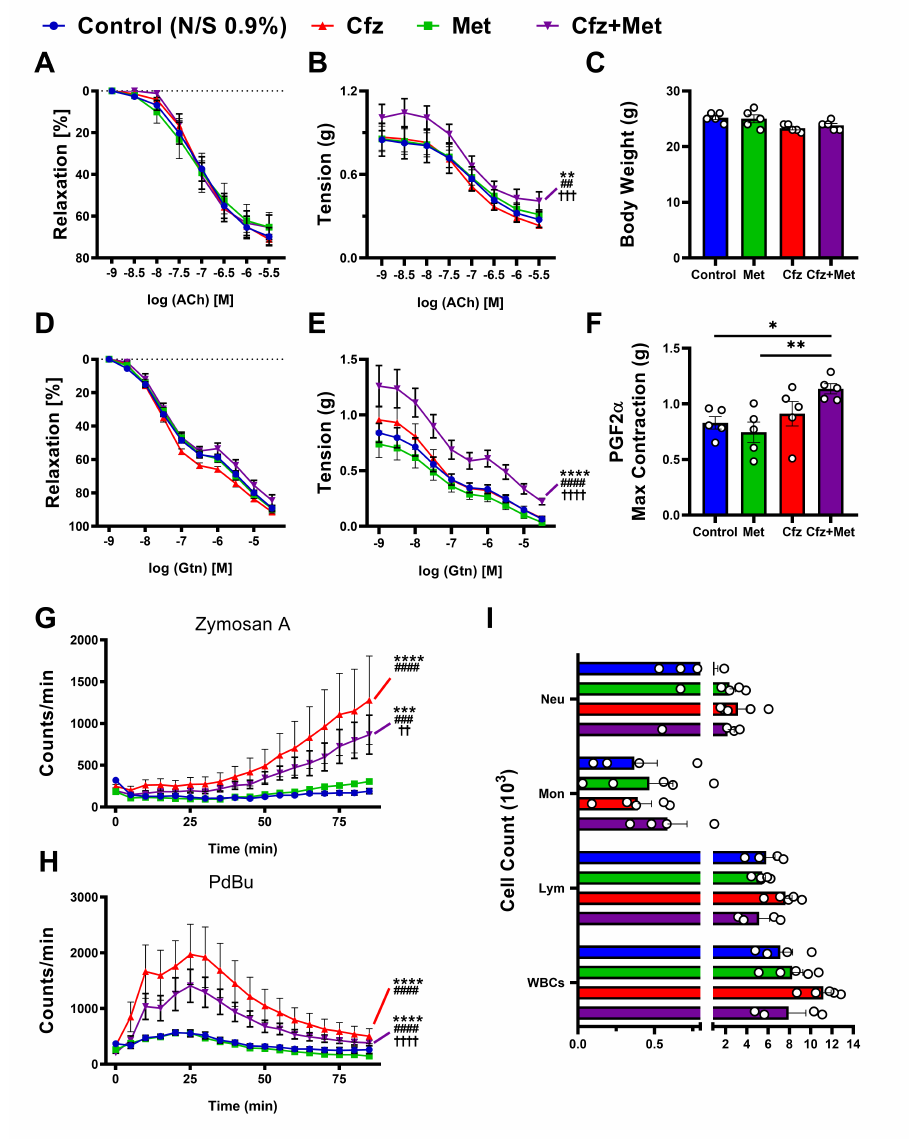
Figure 2. Carfilzomib did not exhibit any vascular deficits in subacute protocol, whilst it induced increased leucocyte derived-ROS release, which was partially inhibited by metformin.